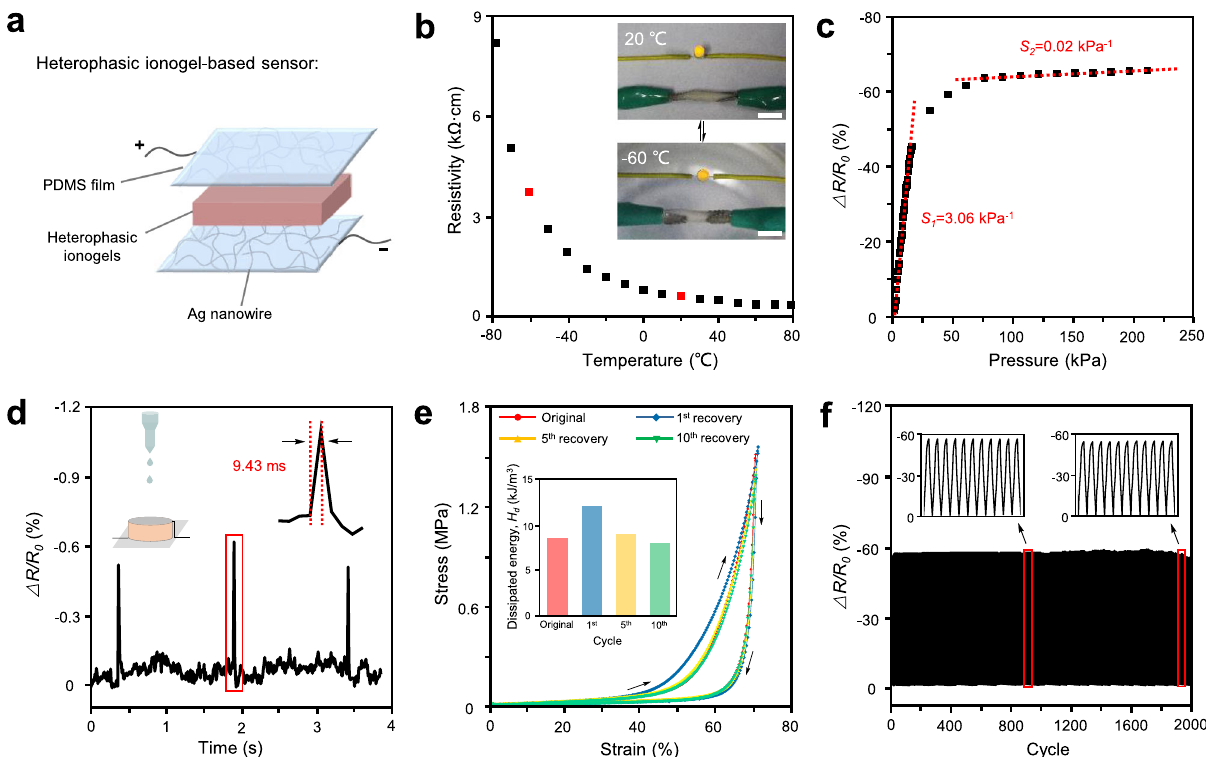
Fig. 2 The pressure-resistance response of the heterophasic ionogel sensors. a Components of the heterophasic ionogel pressure sensors. b Resistivity of the heterophasic ionogels in the temperature range from − 80 to 80 °C. The pictures showed that the heterophasic ionogels could work as wires at − 60 °C. Scale bar, 1 cm. c Relative resistance variation ( Δ R / R S ) of the heterophasic ionogel sensors under different pressures. d The 0 ) and sensitivity ( dynamic response time of the heterophasic ionogel sensor to the fallen droplet. e First loading-unloading cycle of original and recovered heterophasic ionogels at 20 °C. Inset showed the dissipated energy of these samples. f Cyclic tests showing the stable response of the heterophasic